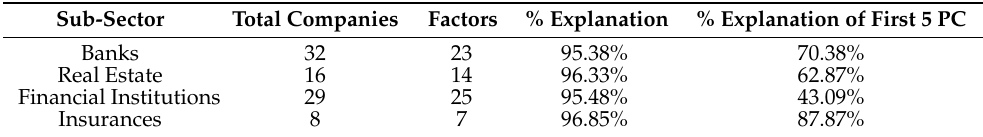
Table 4. Principal Components of covariance matrix.